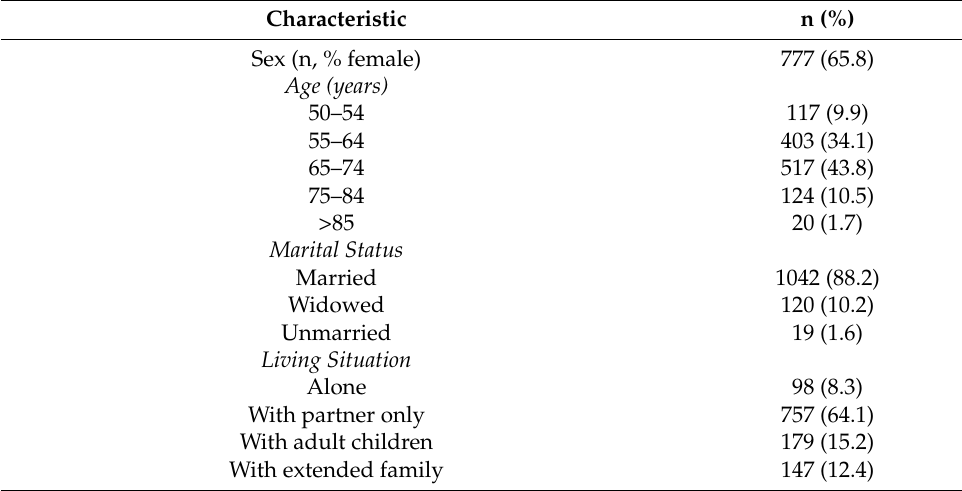
Table 1. Participant Sociodemographic Characteristics, N =